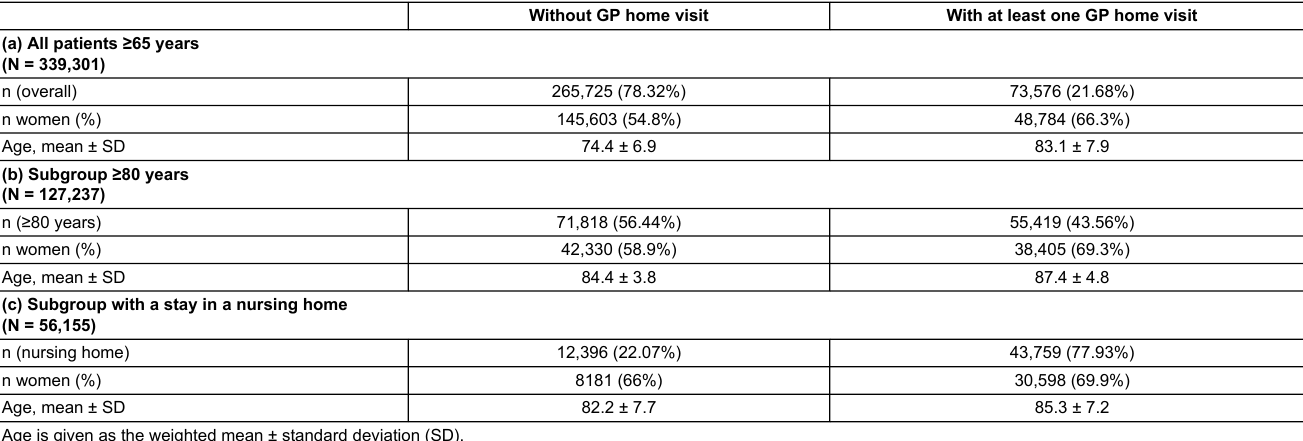
Age is given as the weighted mean ± standard deviation